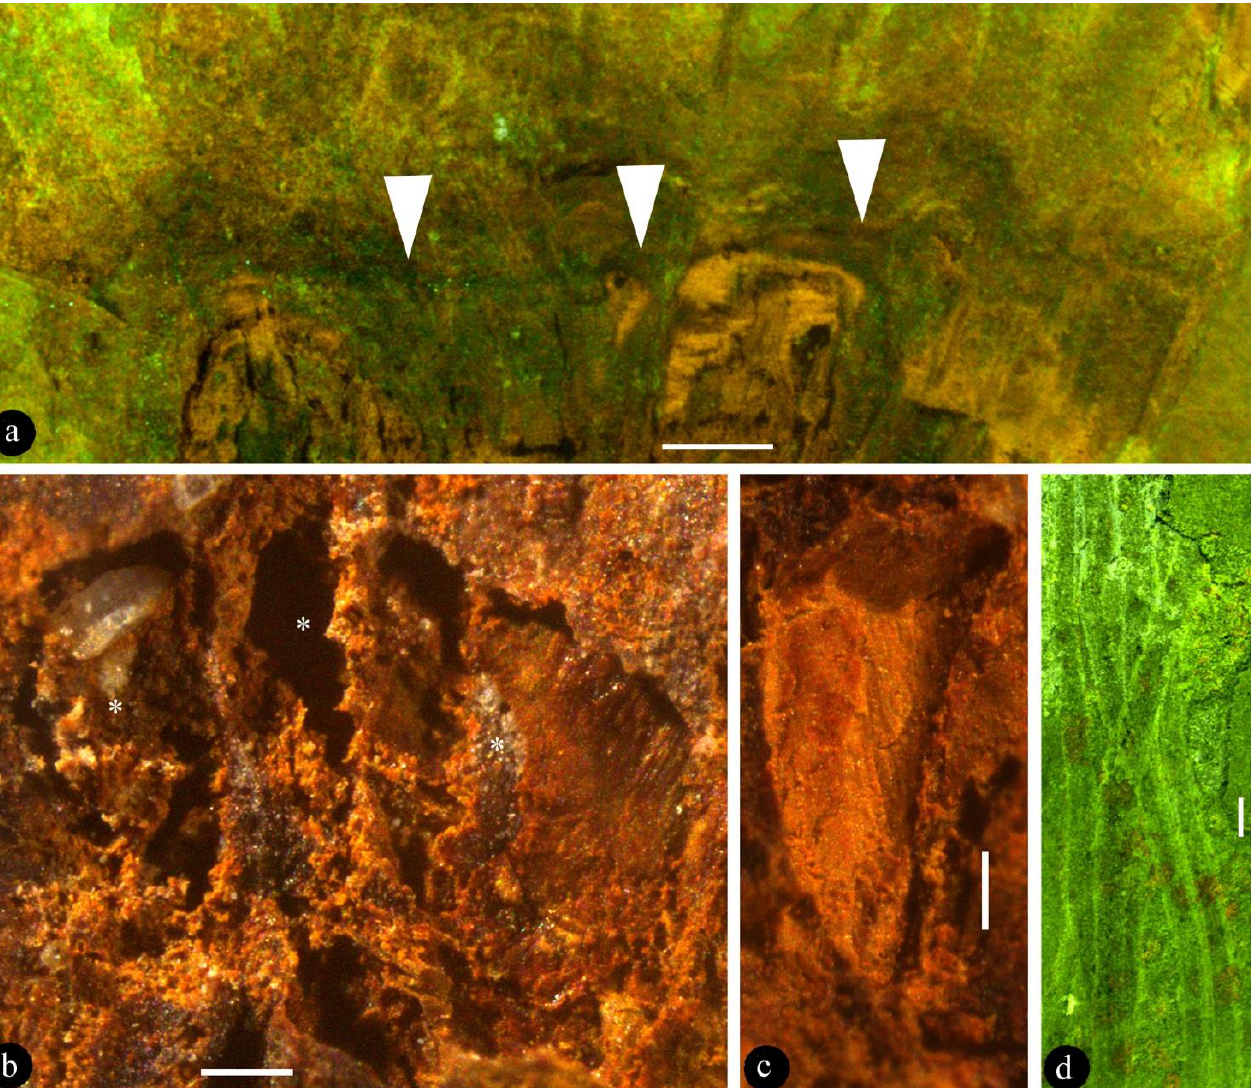
Figure 3. Lingyuananthus inexpectus gen. et sp. nov. ( a ) Flat ovary top (= floral roof, triangles) secluding the ovary. Refer to Figure 4d. Scale bar = 1 mm. ( b ) Three adjacent ovules (asterisks) of various forms in the ovary. Scale bar = 0.2 mm. ( c ) Cuneate profiled cavity left by a fallen-off ovule. Scale bar = 0.2 mm. ( d ) Several linear-shaped tepals. Scale bar = 1 mm.